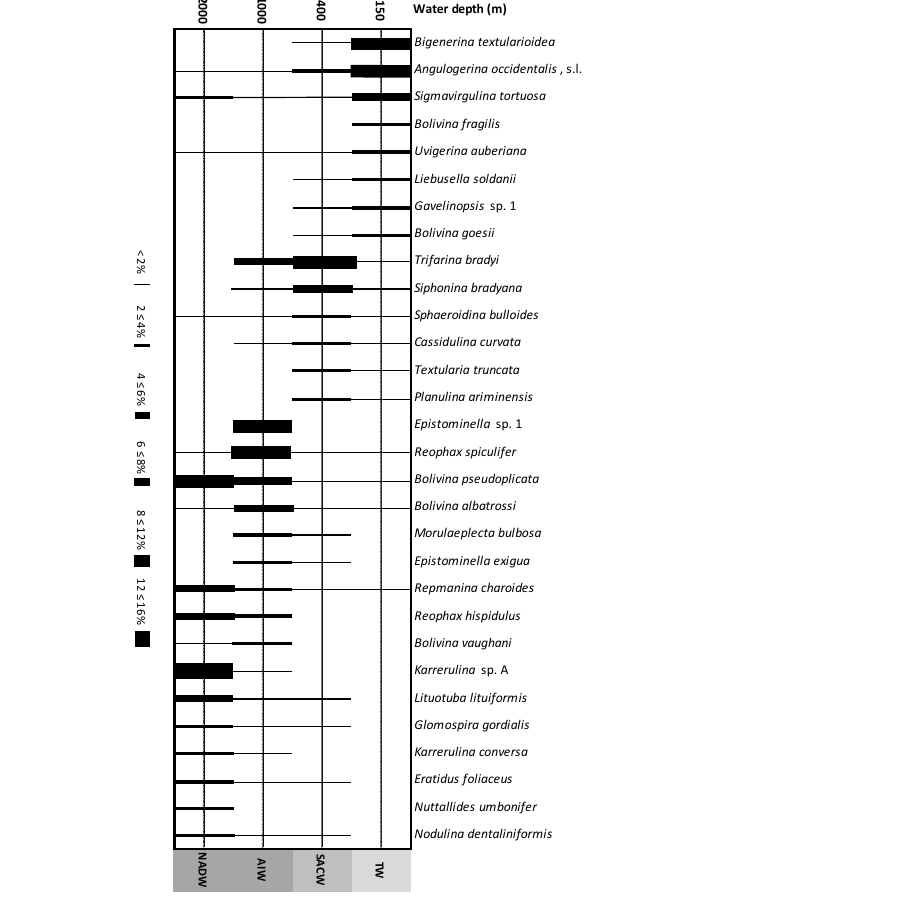
Figure 8. Species and their respective relative frequencies at the superficial layer.